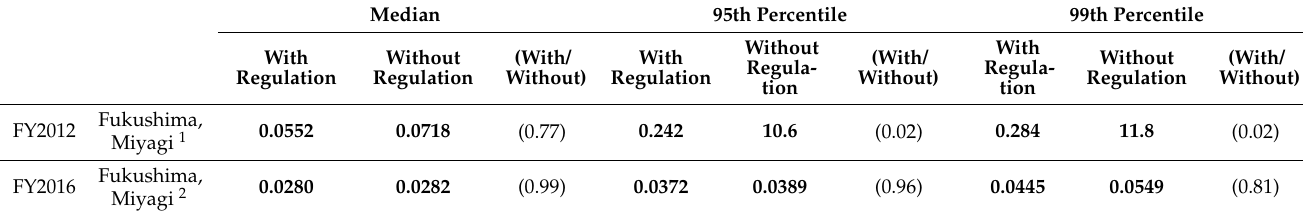
Table 6. Estimated radiation exposure doses in Fukushima and Miyagi area